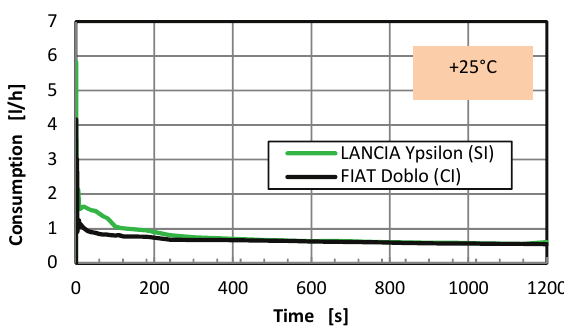
Fig. 5. Instantaneous fuel consumption at the temperature of +25°C For better presentation of the differences in the fuel consumption, Figs 6–8 show the averaged fuel consumption values [l/h] in selected time intervals (of different width).